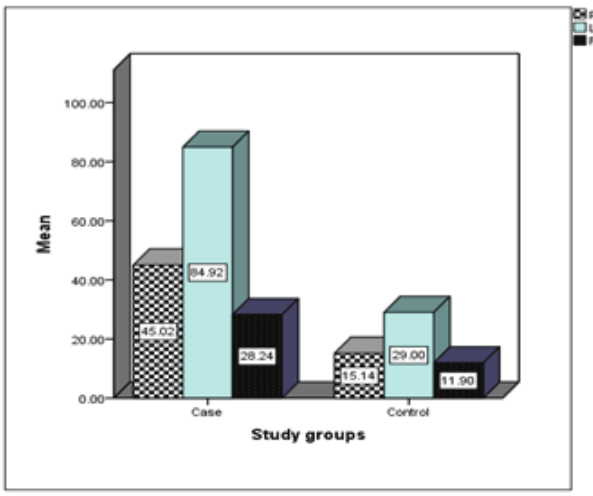
Figure 1 : Means of serum PRL, LH, and FSH in study